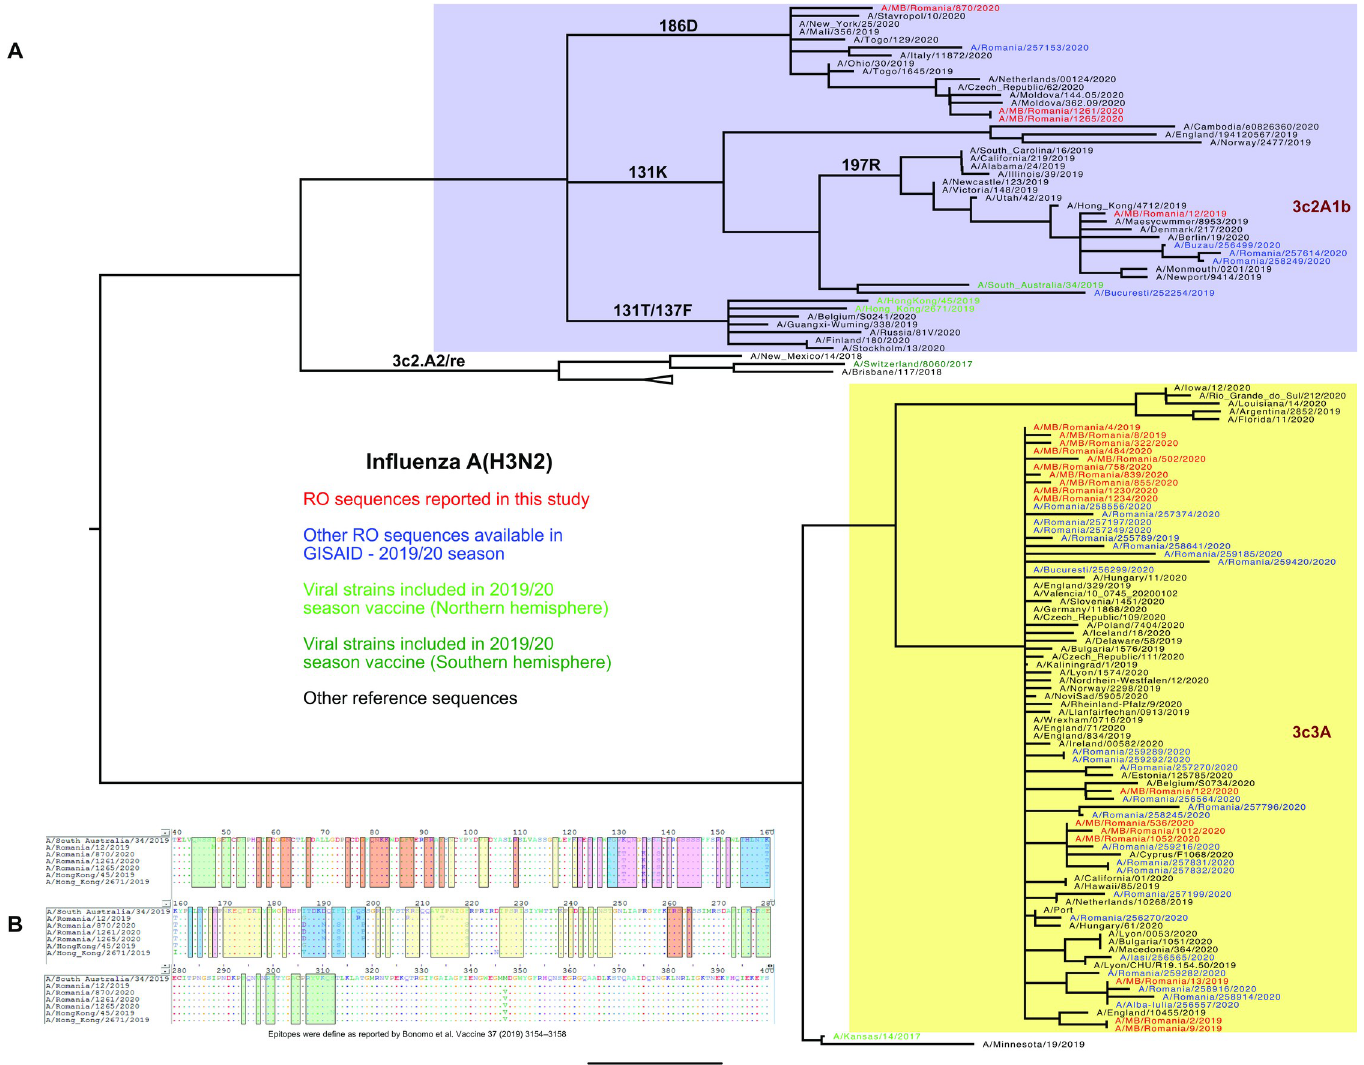
Fig 4. A. Phylogenetic analysis of A(H3N2) hemagglutinin sequences. B. Mutations in antigenic sites identified in HA nucleotide sequences compared with vaccine strains.